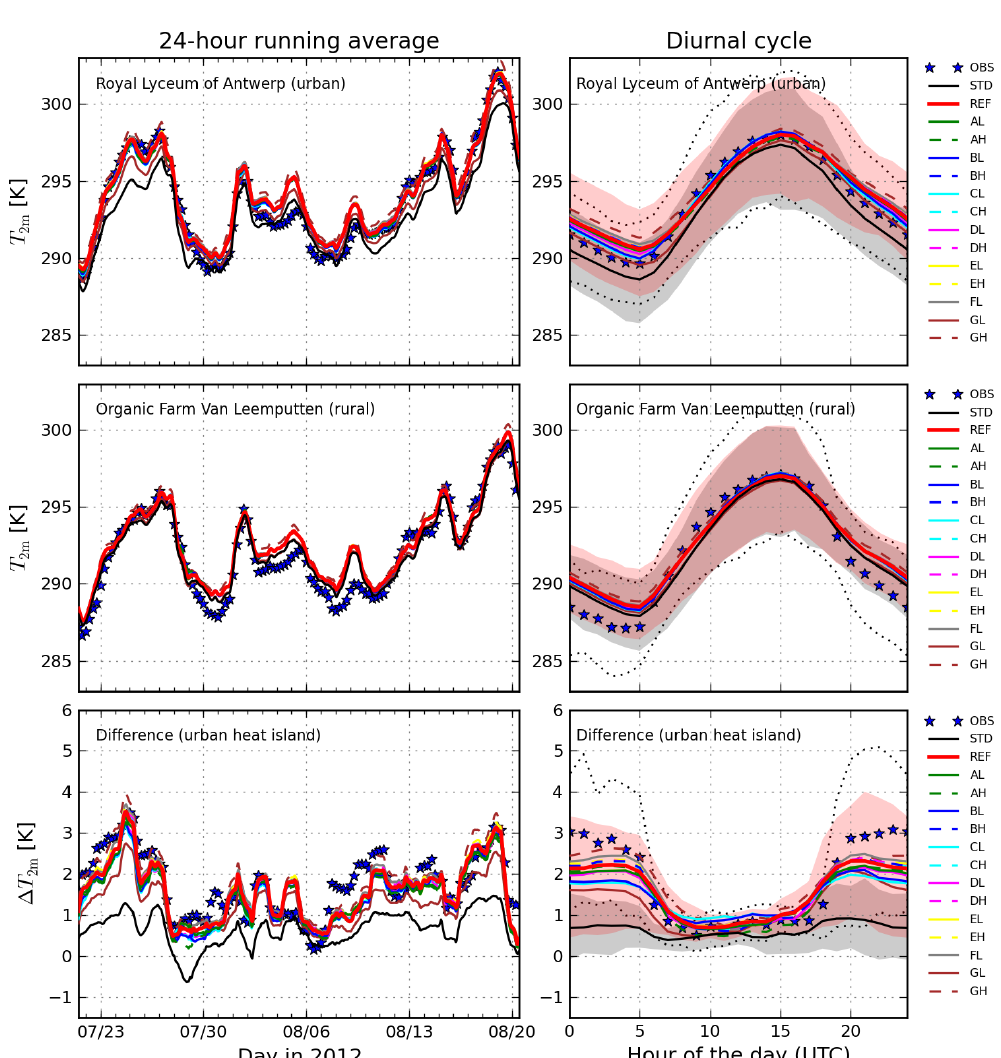
Figure 3. 24h running averages and mean diurnal cycle for modelled (thick lines) and observed (OBS; blue stars) temperatures during mid-summer (21 July to 20 August 2012) at the Royal Lyceum for Antwerp (urban), the Organic Farm Van Leemputten (rural) and their difference (the urban heat island effect of Antwerp). The simulation with the COSMO-CLM model coupled to the standard land-surface module TERRA_ML without urban parametrization is indicated with STD (black), whereas the reference simulation with the COSMO- CLM model plus TERRA_URB v2.0 with urban parametrization is indicated with REF (red). The dotted lines indicate the range between the 16th and 84th percentile of the observed temperatures, whereas the grey and light red areas indicate the ranges for the simulations STD and REF, respectively. An overview of the canopy parameter sensitivity simulations (AL, AH, BL, BH, etc.) can be found in Table